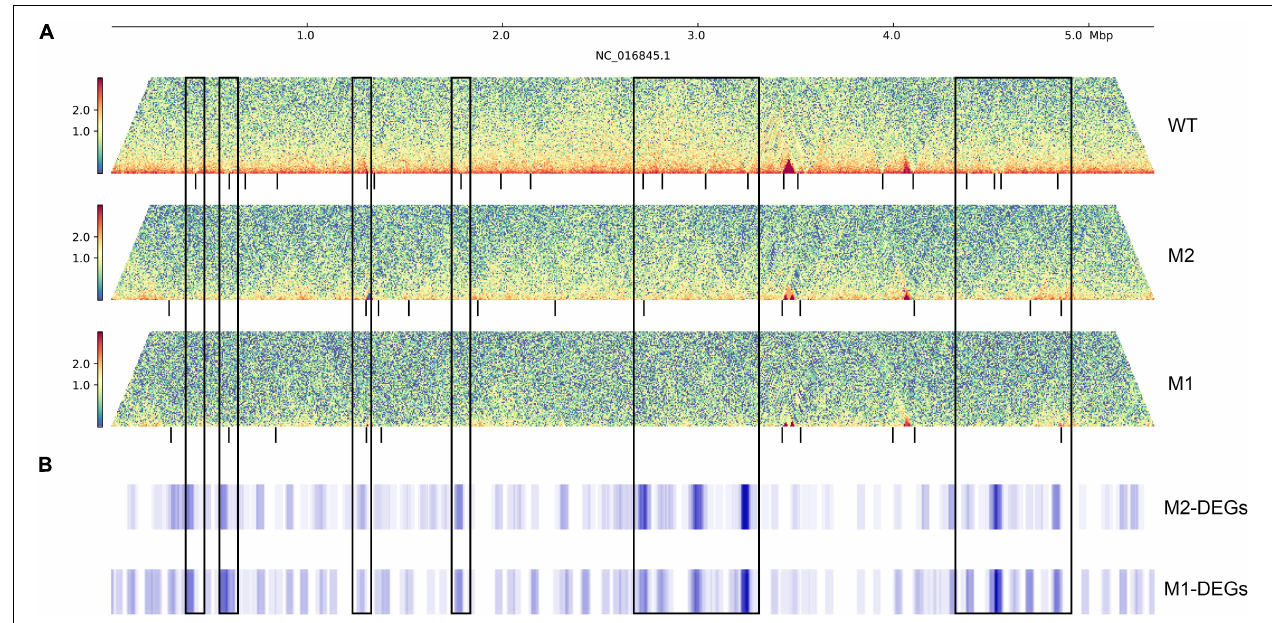
FIGURE 4 | The distribution of DEGs on the genome. (A) Interaction heat map of chromosomes, the black vertical line below represents CID boundaries. The color scale indicates the contact frequency between chromosome regions. Blue indicates low contact frequency and red indicates high contact frequency. (B) Distribution of DEGs in the genome. The black box represents the CID boundaries with DEGs